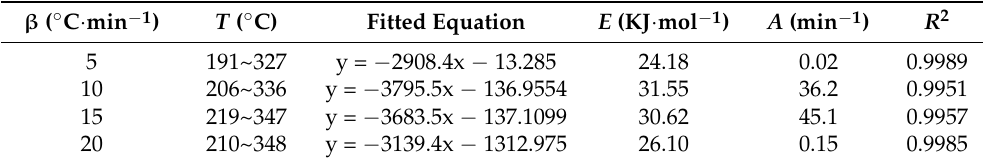
Table 3. The thermal decomposition kinetic parameters of the chicken manure in the presence of nitrogen atmosphere.